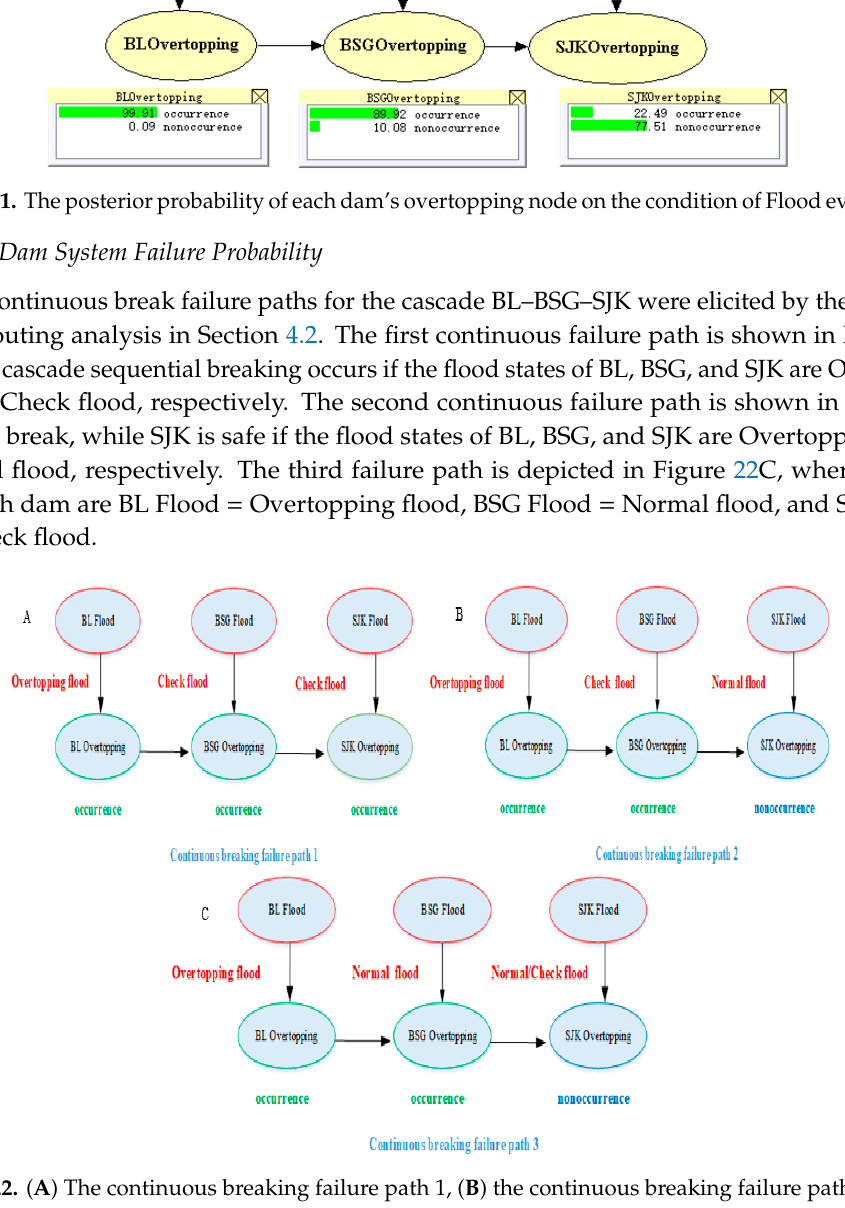
Figure 23. The cascade system failure probability of failure path 2. As shown in Figure 23, the calculated model of system failure probability was established with a focus on the impacts of every dam on the cascade dam system. The prior probability of each dam was obtained with the consideration of the failure path states and the CPTs (Tables 4 and 5) in this model. For instance, check flood occurs at the BSG dam and the upstream BL dam is overtopped in this path; thus, the prior probability of BSG Overtopping = occurrence is 0.75, which can be obtained in Table 4. According to continuous breaking path 2, the evidence is set as P (BL Overtopping = occurrence) = 1, P (BSG Overtopping = occurrence) = 1, and P (SJK Overtopping = nonoccurrence) = 1, and then the system failure probability is computed as P (system = normal) = 0.3335 and P (system = failure) = 0.6665.